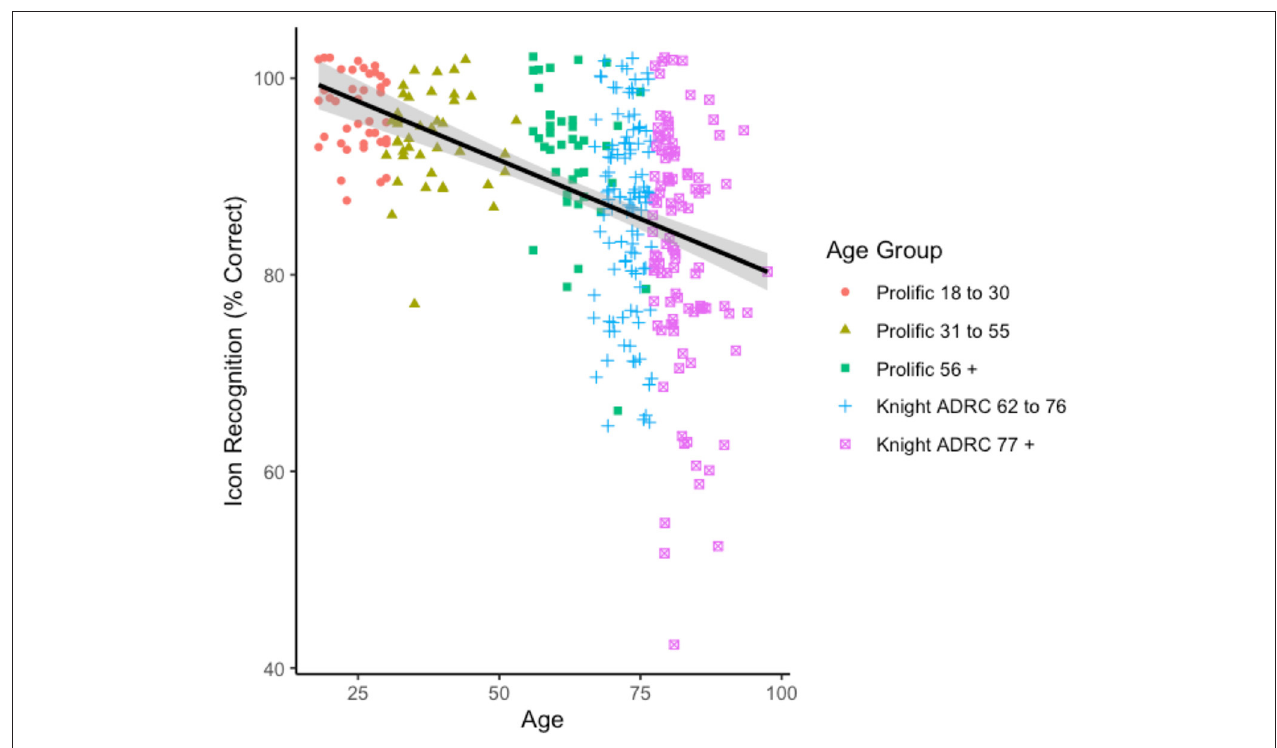
FIGURE 1 | Icon recognition scores by